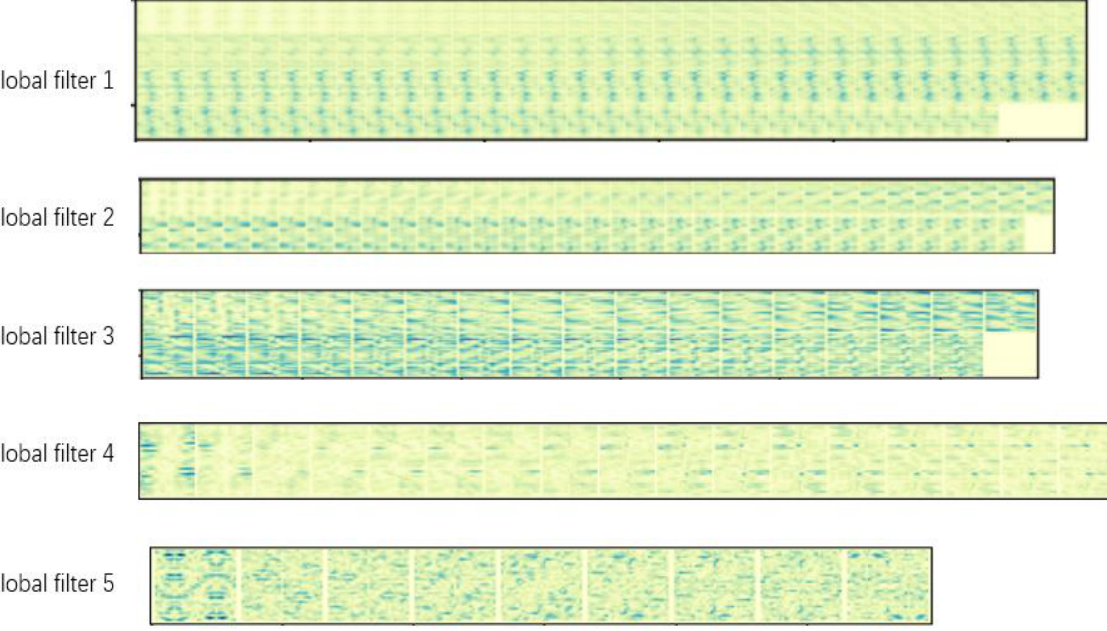
Figure 6. Visualization of the global filters. A visualization of the 5 global filters of MFGFNet is included in Figure 6.